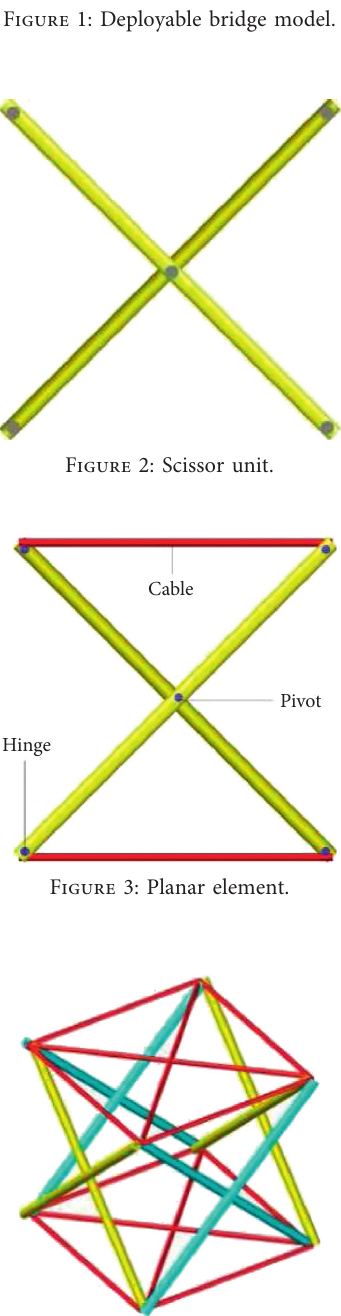
Figure 4: Three-dimensional